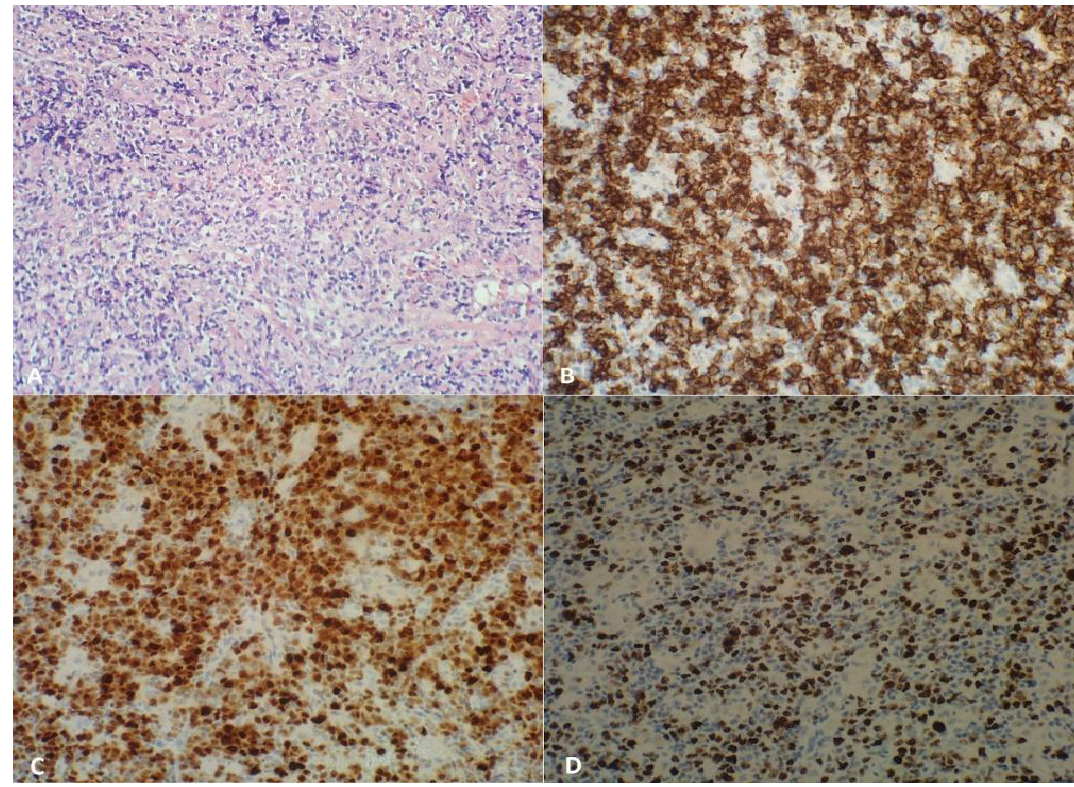
Figure 4. Neoplastic carotic lymph nodes detected at the age of 6.5 years: Large B-cell lymphoma with IRF4 rearrangement ( × 400). ( A ) Hematoxylin-eosin stain: atypical lymphoid cells ( × 400). ( B ) CD20-positive cells ( × 400). ( C ) MUM.1-positive cells ( × 400). ( D ) High count of Ki-67-positive cells ( × 400). Table 3. Treatment according to the B-HR arm of the Inter-B-NHL-COP 2010 with dose reduction